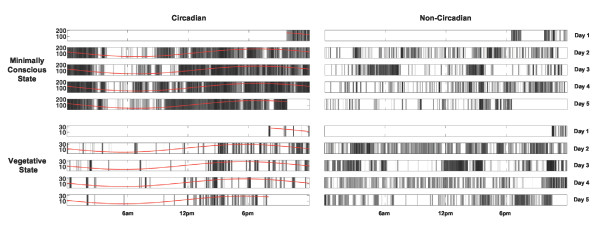
Actigraphy data from four representative patients. Each panel shows intensity of activity across each recording day. Red lines indicate the fit of the circadian rhythm. Note the periodic structure of the activity of the two patients with significant rhythms (left), compared with those without (right). Patients 19, 21, 52 and 45 are shown (clockwise from top-left). Log activity data smoothed across five minutes is plotted for clarity of visualization.